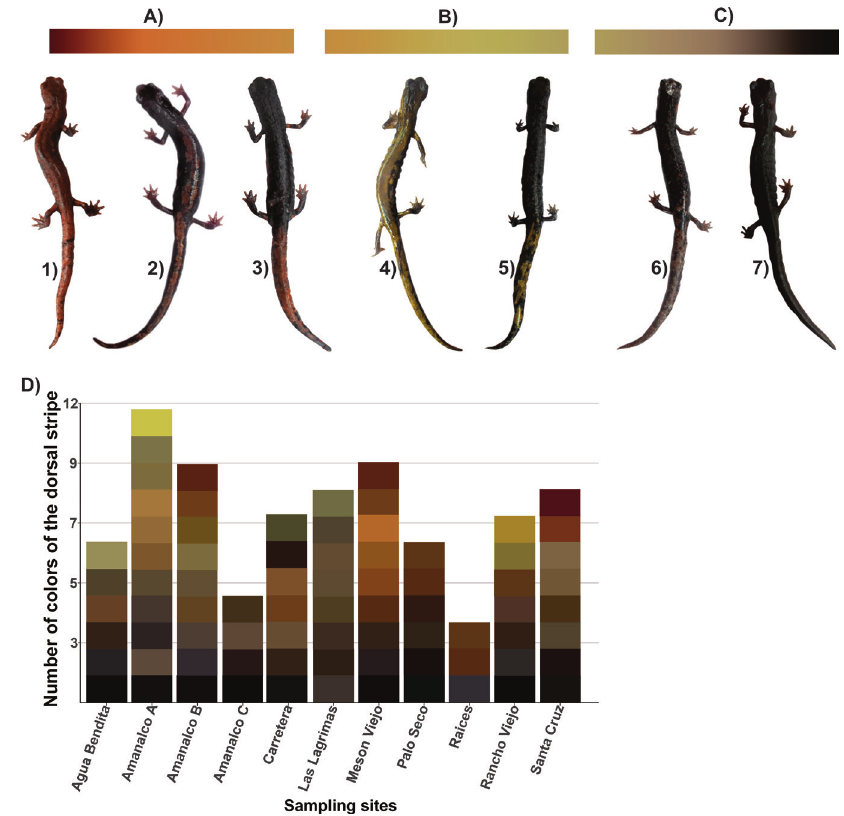
Figure 6. Dorsal stripe coloration types in P. robertsi ( A–C ) and proportion of colors per site, ranging from red to orange ( A, B ) and from brown to black ( C ), different dorsal patterns found: 1) well-defined, brick red dorsal stripe; 2) dense dorsal mottling; 3) dorsal red line only present on the tail; 4) semi well-defined, yellow dorsal stripe; 5) dorsal yellow line only present on the tail; 6) few scattered spots in the dorsal line and in the tail; 7) all black without spots or dorsal line; D) color patterns of the dorsal stripe in the different sampling